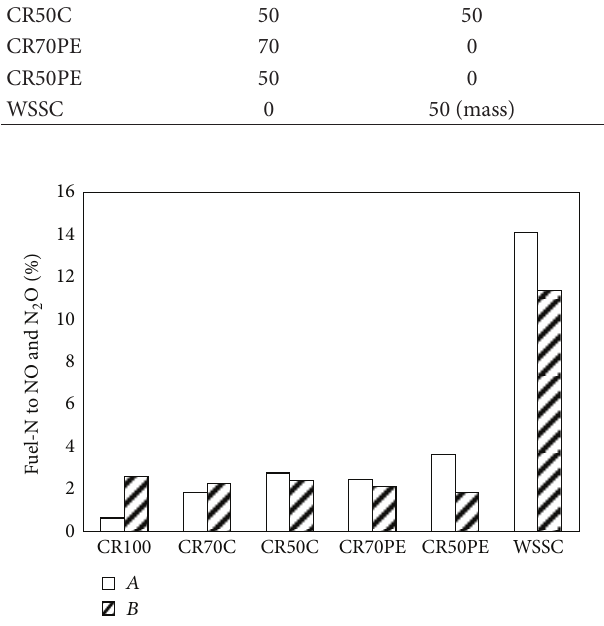
Figure 7: Influence of cofiring rate on NO emission. A: N 2 O; B: NO; CR100:CRno.100%; CR70C:CRno.70%, coal; CR50C:CRno.50%, coal;CR70PE:CRno.70%,PE;CR50PE:CRno.50%,PE;WSSC:wet sewage sludge and